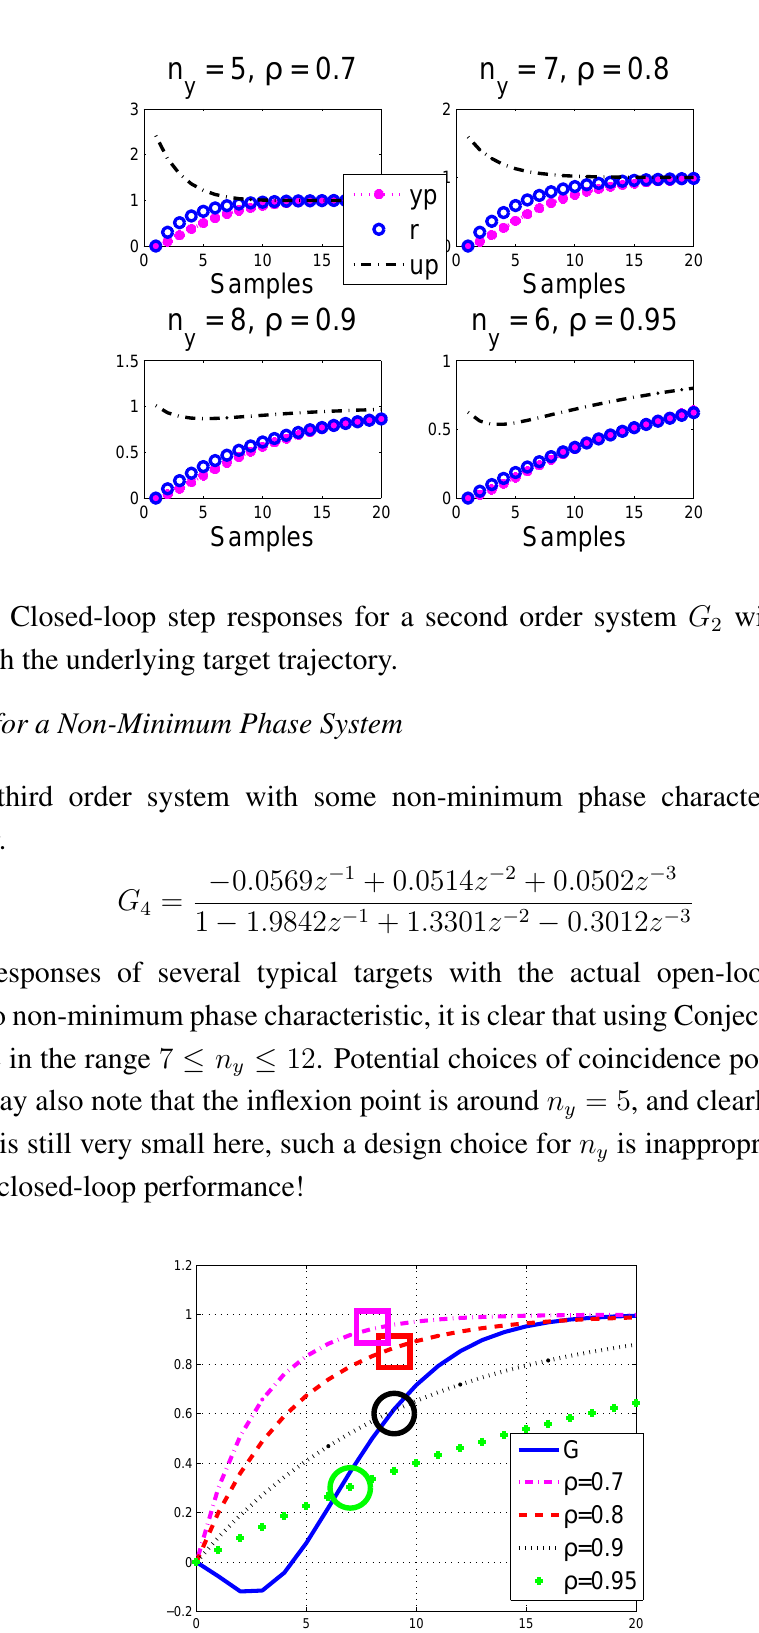
overlaid with several possible targets and potential 4